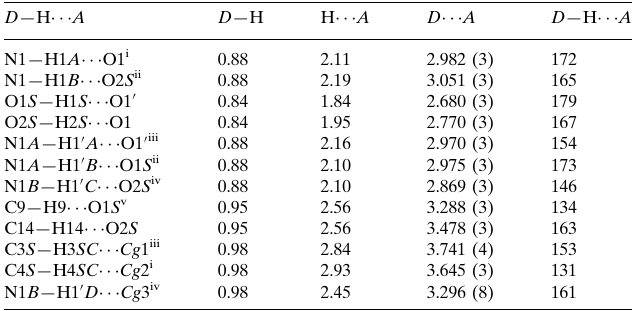
Hydrogen-bond geometry (A˚ , (cid:2)